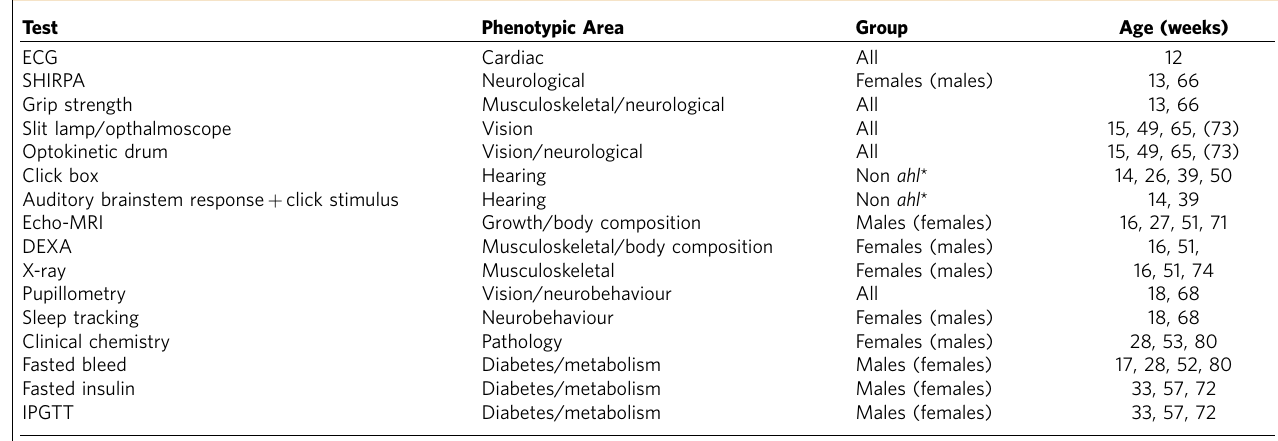
Table 1 | The Harwell Ageing screen phenotyping